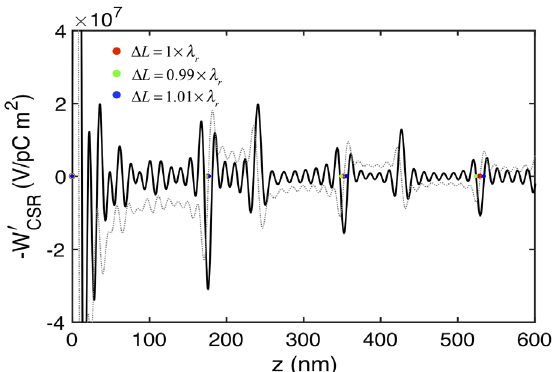
the microbunch trains with Δ L ¼ λ r , Δ L ¼ 0 . 99 λ r , and Δ L ¼ 1 . 01 λ r . One can see from the figure that when the bunch spacing is equal to the resonant wavelength, i.e., the red dots, the individual microbunches are located around the bottom of the potential well. When the bunching spacing deviates from the ideal case, the more leading microbunches deviate further from the bottom of the well and experience a stronger radiation fields (dashed line).